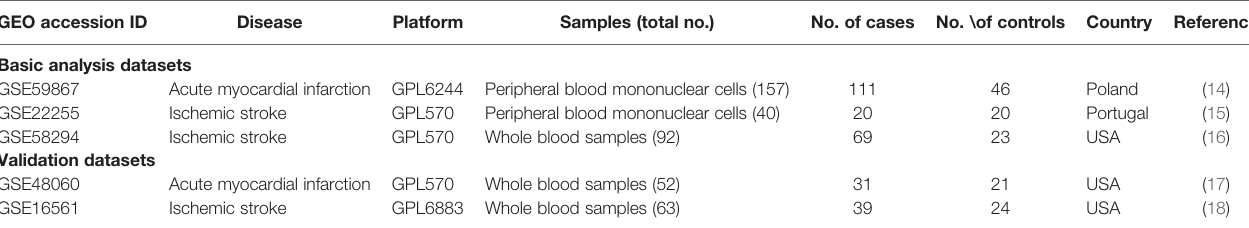
TABLE 1 | GEO dataset information.